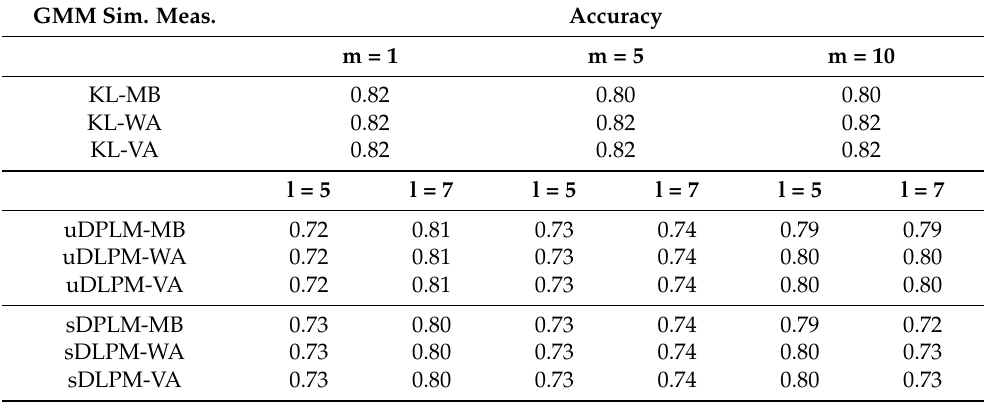
Table 1. Recognition accuracies for DPLM-based and KL-based measures on the UIUC database. GMM Sim. Meas.